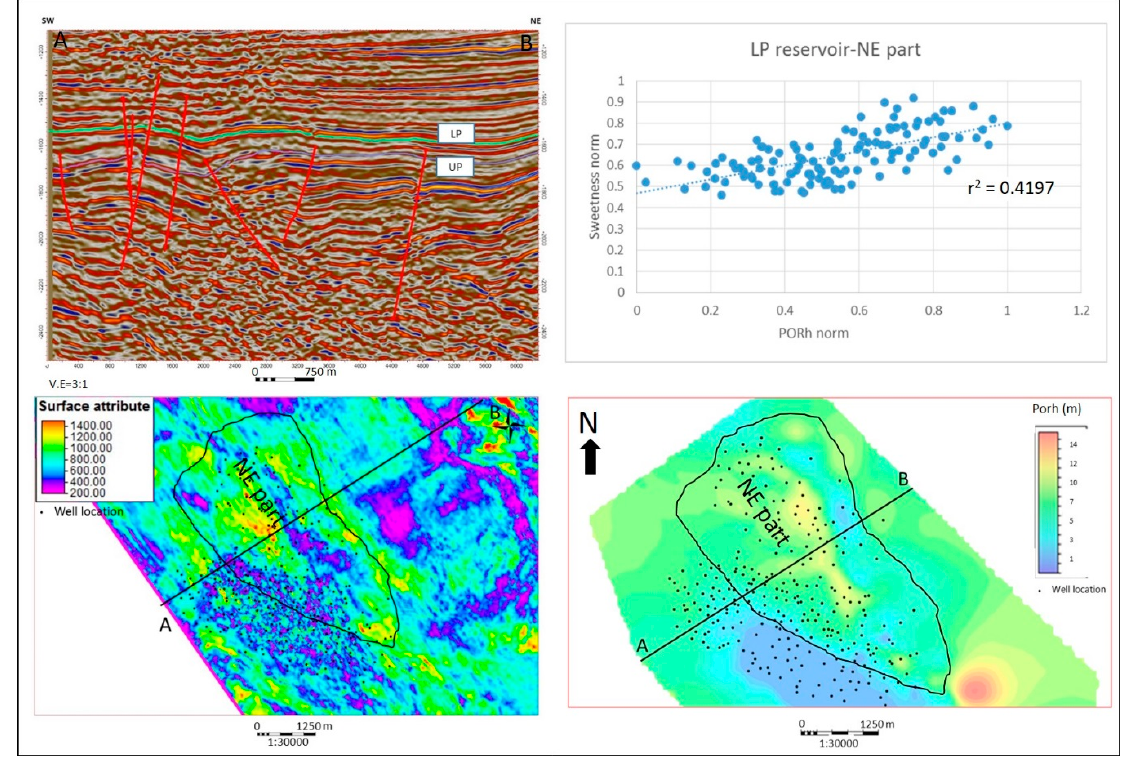
Figure 14. Correlation of the sweetness attribute and porosity–thickness map of the north-eastern part (NE part) of the “LP” reservoir [29]. Geosciences 2018 , 8 , x FOR PEER REVIEW